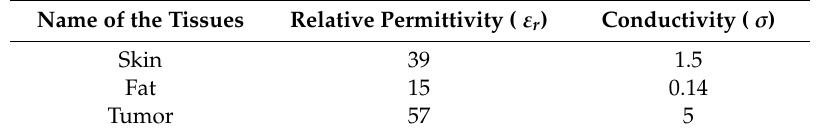
Figure 11. Proposed breast imaging setup: ( a ) Breast phantom tissues layer with and without tumor; ( b ) Right side view of 16-antenna array imaging setup; ( c ) Top view of 16-antenna array imaging setup; ( d ) The relative permittivity of different tissue layers of the phantom. Table 3. The dielectric properties of the human breast tissues with tumor at 3.00 GHz